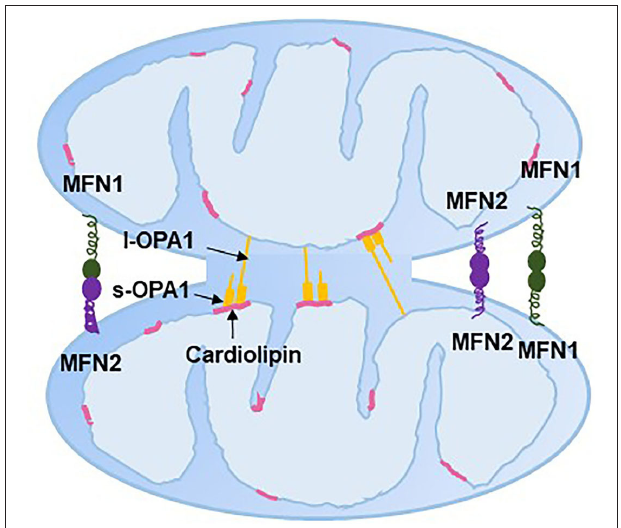
FIGURE 5 | Mitochondrial fusion. ER, endoplasmic reticulum; MFN, mitofusin; l-OPA1, long-optic atrophy 1; s-OPA1, short-optic atrophy 1.